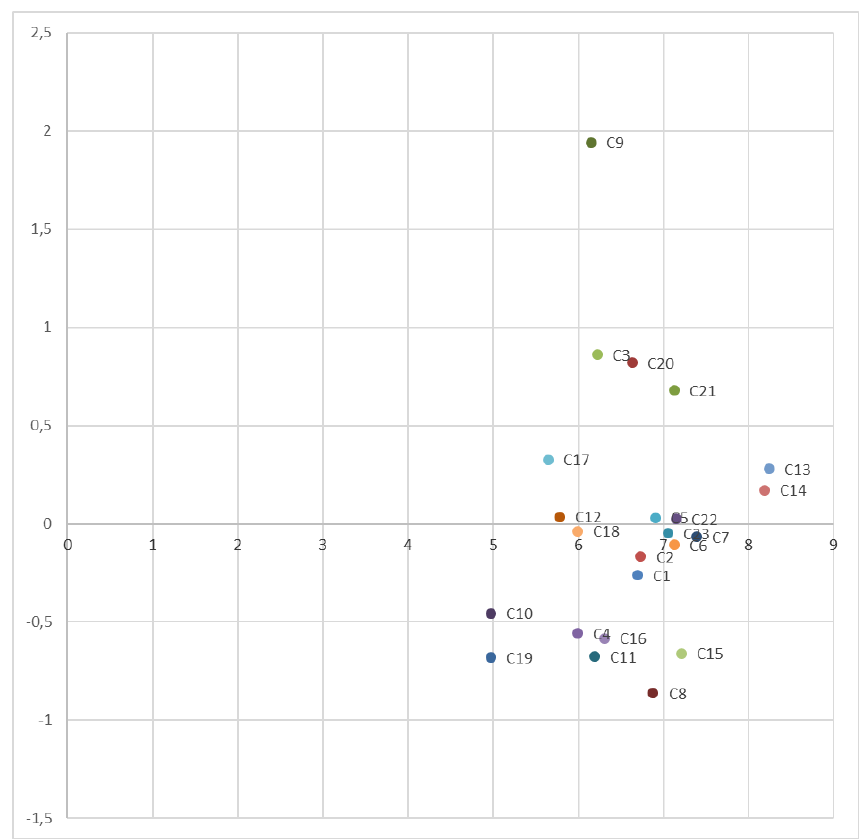
Figure 3. The cause - effect